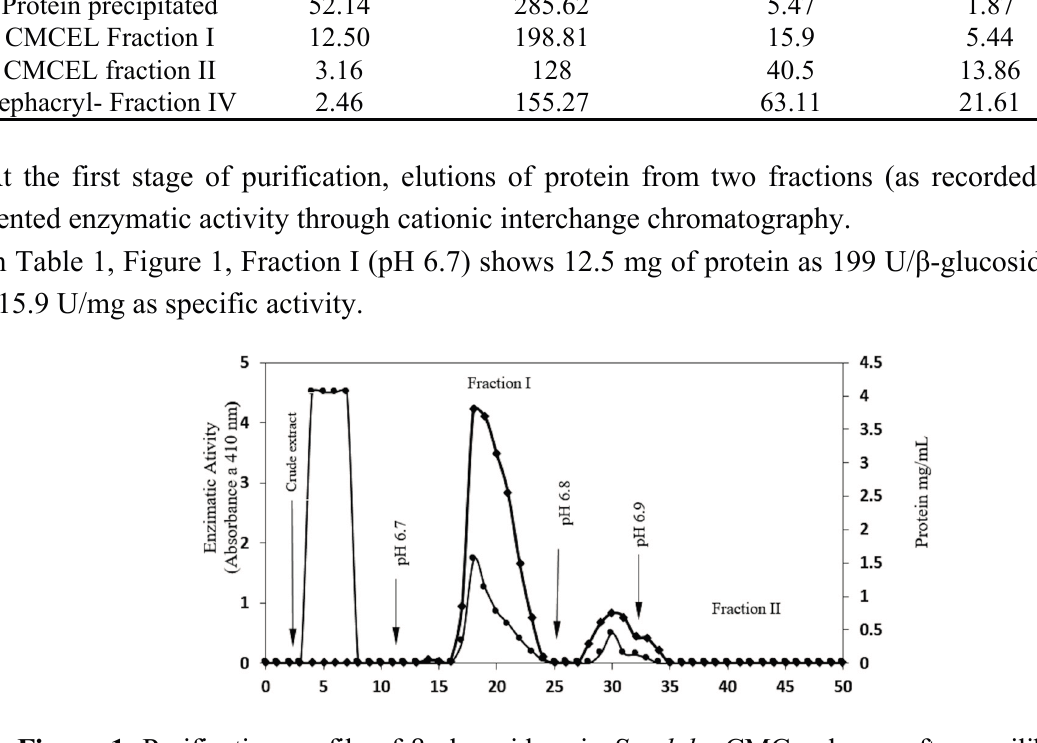
Figure 1. Purification profile of β -glucosidase in S. edule . CMC column, after equilibration with acetate buffer (0.2 M, pH 5), 50 mg of protein from crude extract was applied. The column was washed with acetate buffer until O.D at 280 nm was <0.01, and then eluted using a phosphate buffer at ph 6.7, 6.8, and 6.9. Flow was 35 mL/h, 1 mL fraction was collected. Enzymatic activity ( ♦─♦ ) and protein concentration ( ●─● ) was determined for each